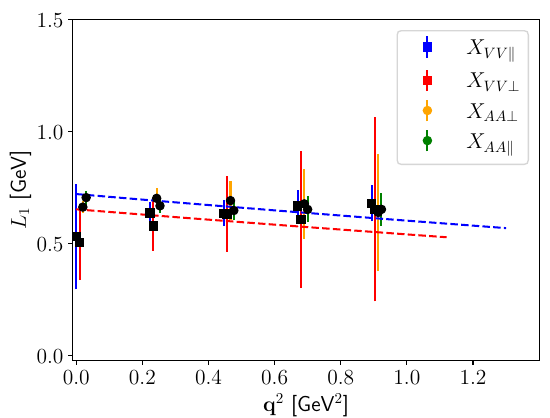
Figure 3 . h H 1 i (left panel) and h H 2 i (right panel) for each channel. The dashed lines are those q 2 q 2 of the expected contribution from the ground state.